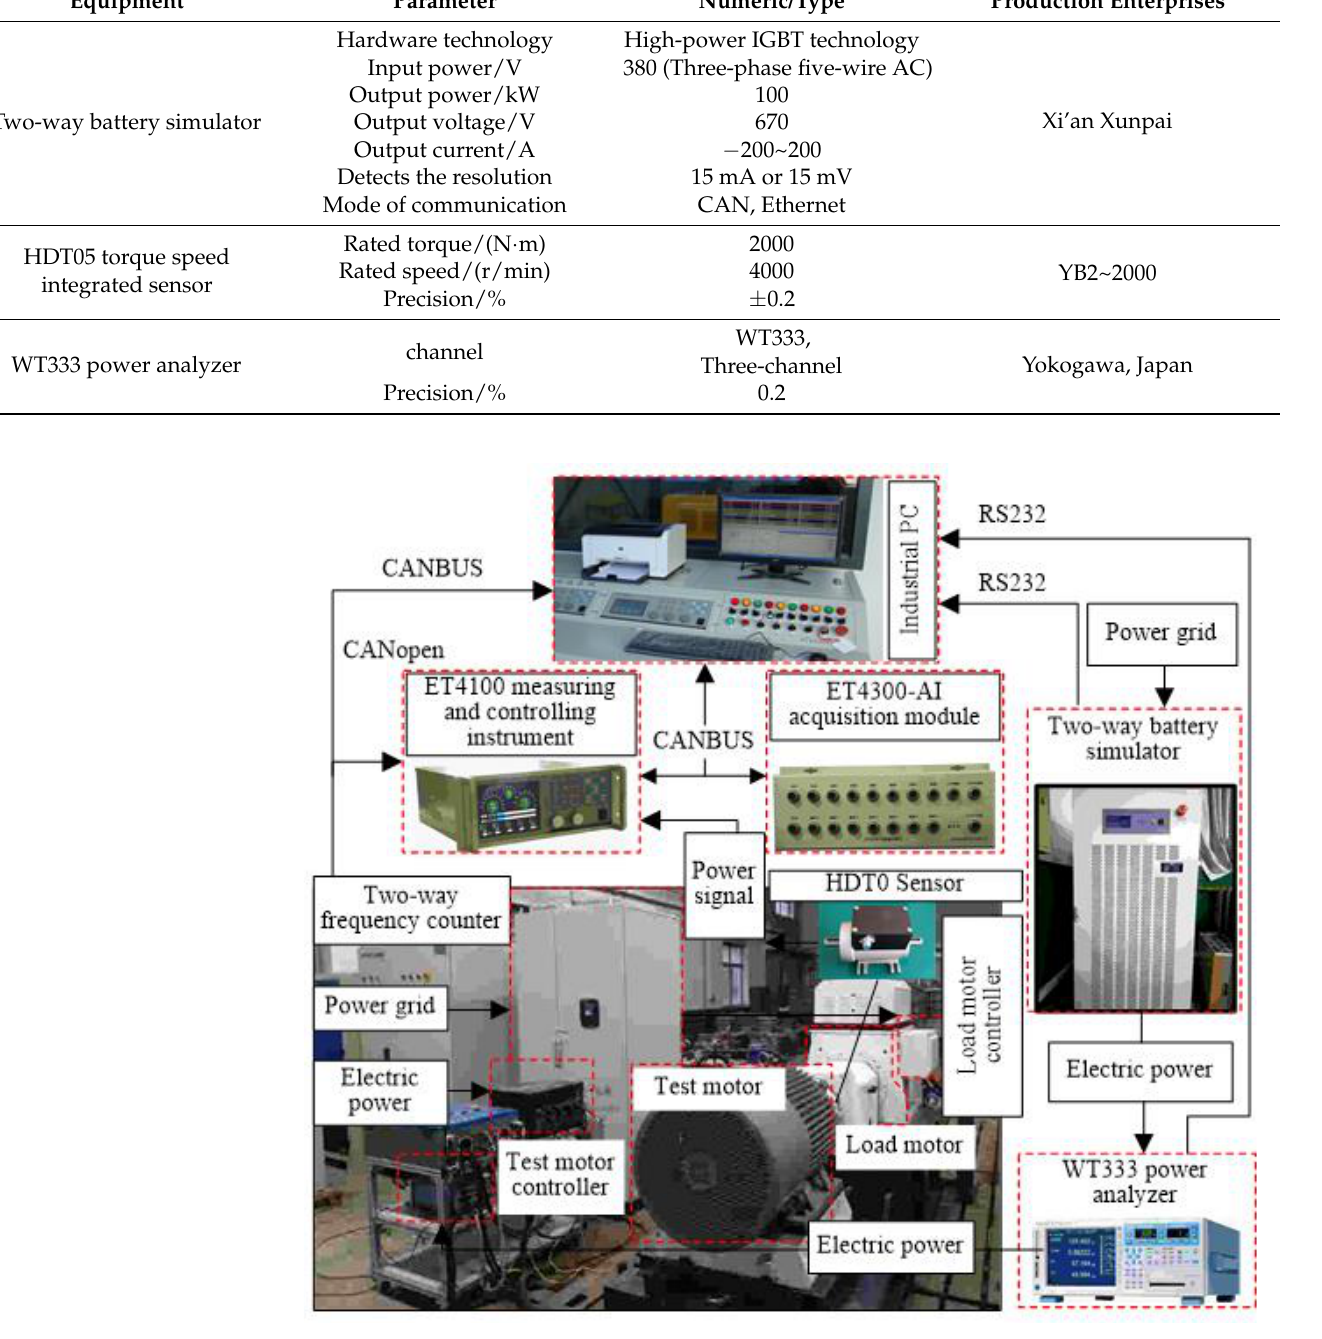
Table 2. Hardware device parameters.